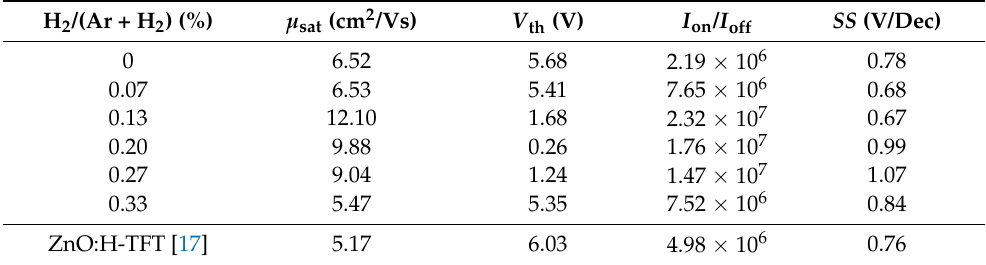
Table 1. The device characteristics of ZnO:H/ZnO-TFTs fabricated with different H 2 /(Ar + H 2 ) and ZnO:H-TFT fabricated at H 2 /(Ar + H 2 ) = 0.10%. H 2 /(Ar + H 2 ) (%) µ sat (cm 2